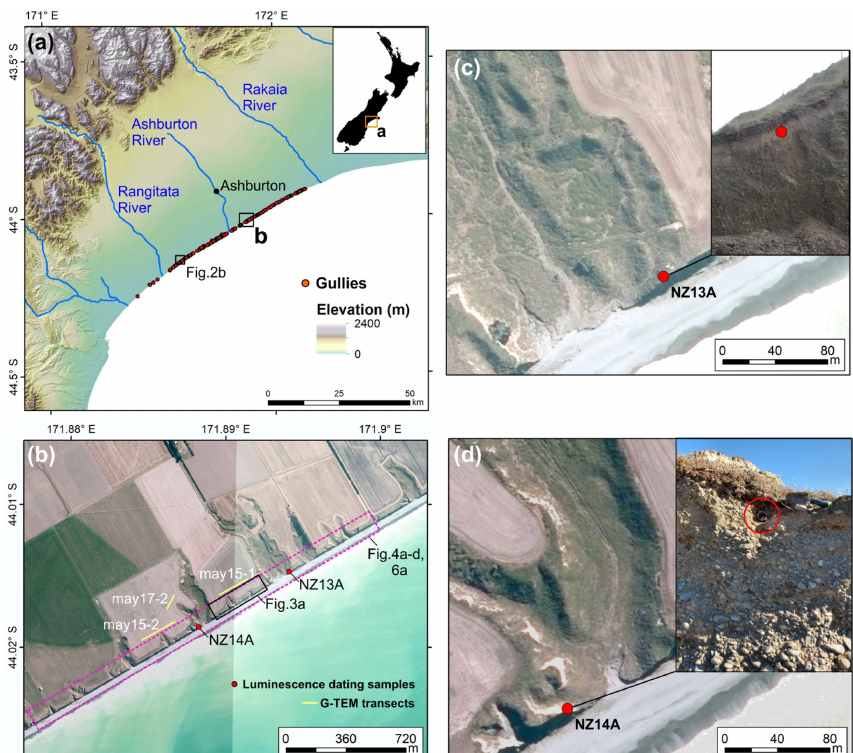
Figure 1. (a) Digital elevation model of the Canterbury Plains (source – Environment Canterbury), located along the eastern coast of the South Island of New Zealand, showing the location of mapped gullies. The location of figure is shown in the inset. (b) Mosaic of aerial pho- tographs of the study area (see a for location; source – Environment Canterbury). The location of luminescence dating (optically stimulated luminescence – OSL) samples, G-TEM transects and other figures is shown. (c–d) Enlarged sections of the aerial and site photographs of the luminescence-dating sampling sites of NZ13A and